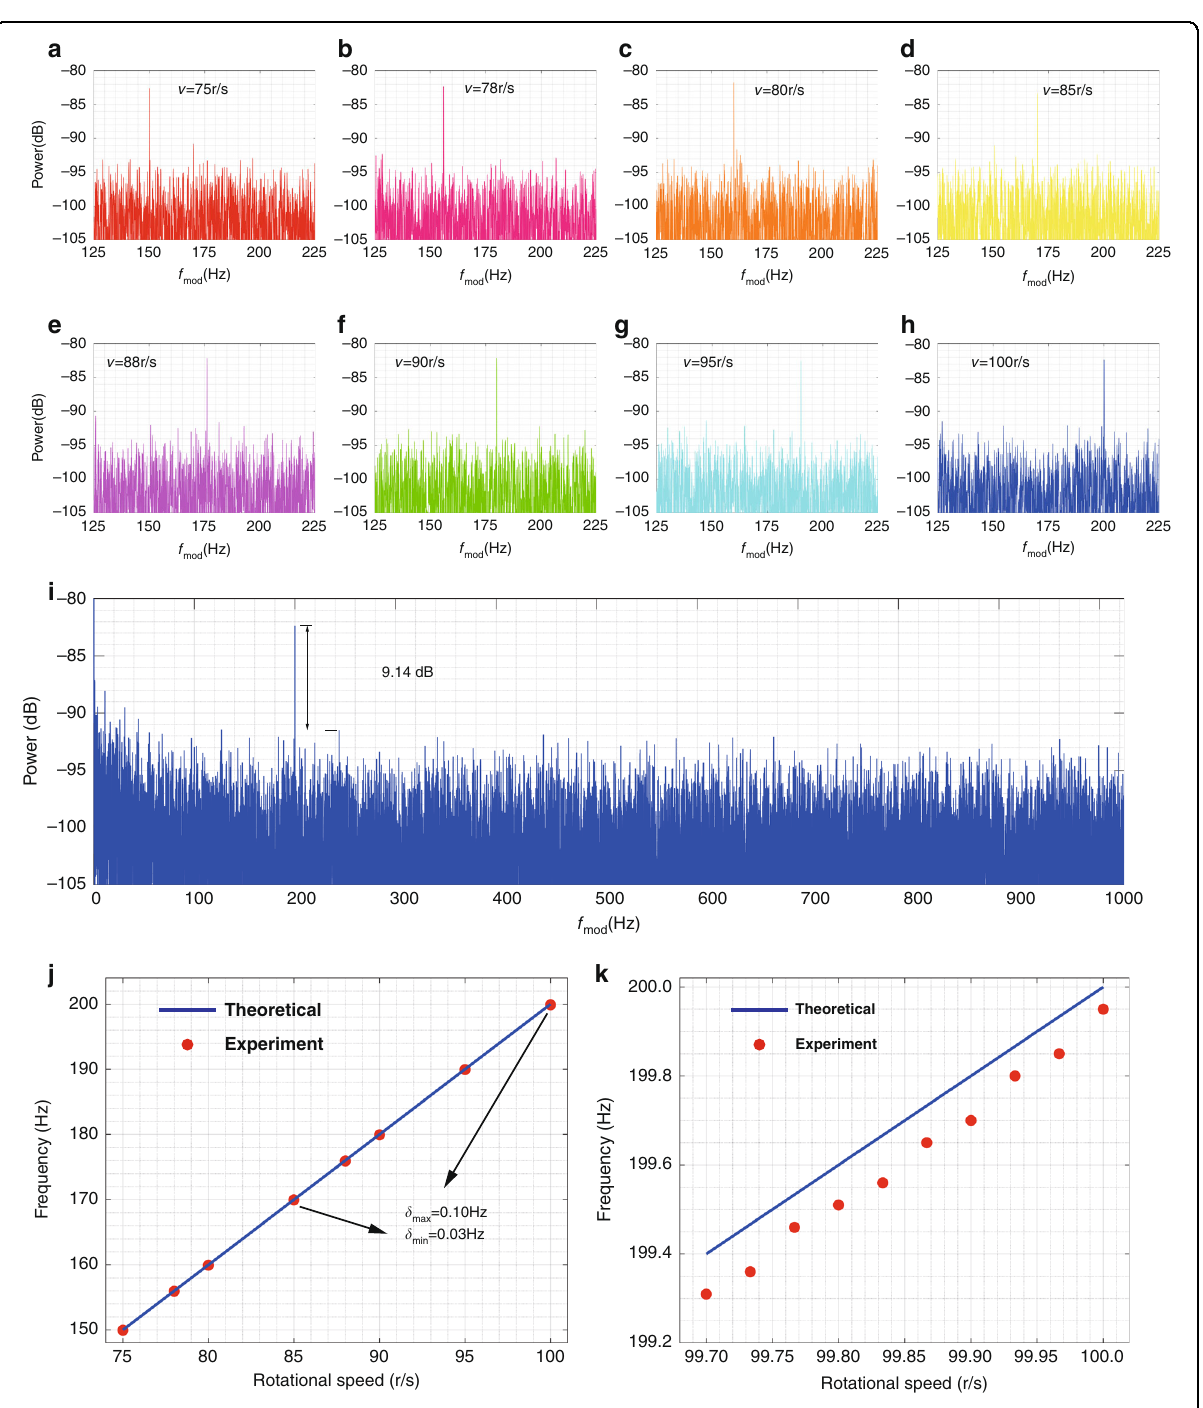
Fig. 4 Measurement results of rotating speed using BGb generated on-chip. a – h The observed power spectrum at the indicated rotational speed over a data collection period of 20 s. i Detailed power spectrum with 0 – 1000 Hz at 100 r/s. j The measured results at different rotating speeds (75 – 100 r/s). k The velocity resolution measurement, there are ten rotational speeds at a step of 0.033 r/s from 99.7 r/s to 100 r/s. For j and k , the red points are the measured data, and the solid blue lines are the theoretical